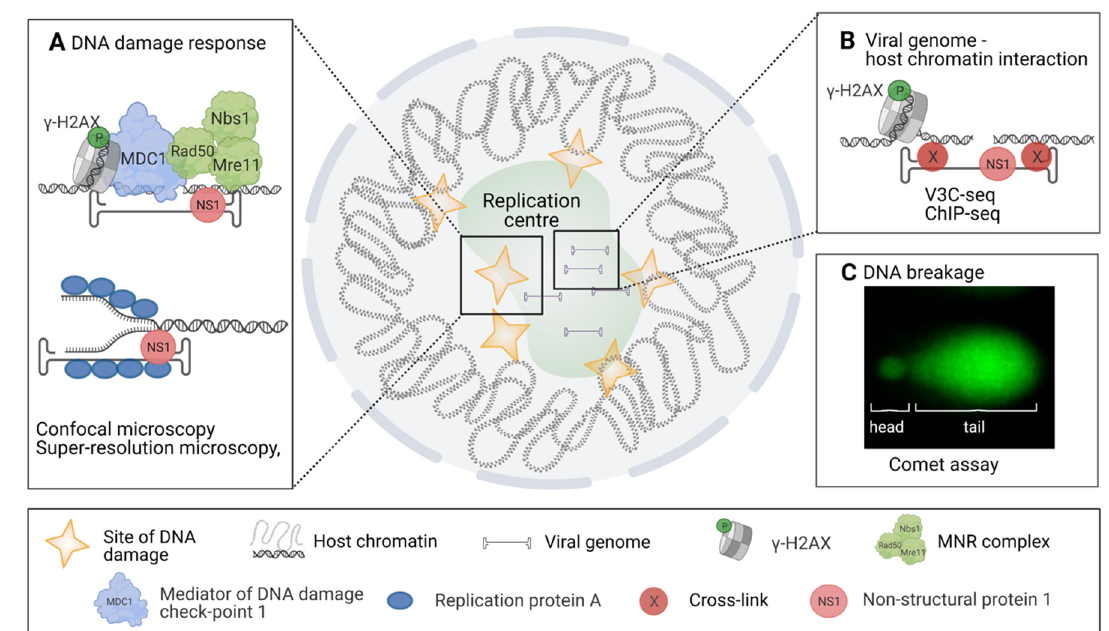
Figure 3. Approaches revealing virus-induced DNA damage. The schematic diagram of diverse methods for the analyses of DNA damage response (DDR), viral and host DNA interactions, and DNA damage in infection. ( A ) Analyses of ATM and ATR-mediated DNA damage signalling pathways by confocal and super-resolution microscopy, ATM-mediated cellular response to DNA damage functions through phosphorylation of proteins related to DNA damage and DNA damage repair such as γ -H2AX, MDC1, Rad50, Nbs1, and Mre11. In MVM infection these proteins are found in replication start sites together with viral NS1. In parvovirus-infected cells, the ATR-mediated response depends on RPA and viral NS1 interaction. ( B ) Elucidation of interactions between viral genome and host cell chromatin by using high-throughput viral chromosome conformation capture sequencing assay (V3C-seq). Moreover, association of DNA damage site MVM genomes has been shown by ChIP-seq. This analysis has been used to verify the association between NS1-mediated viral genome replication and DDR. ( C ) Studies of host cell chromatin disintegration by comet assay. Images were created with BioRender.com.